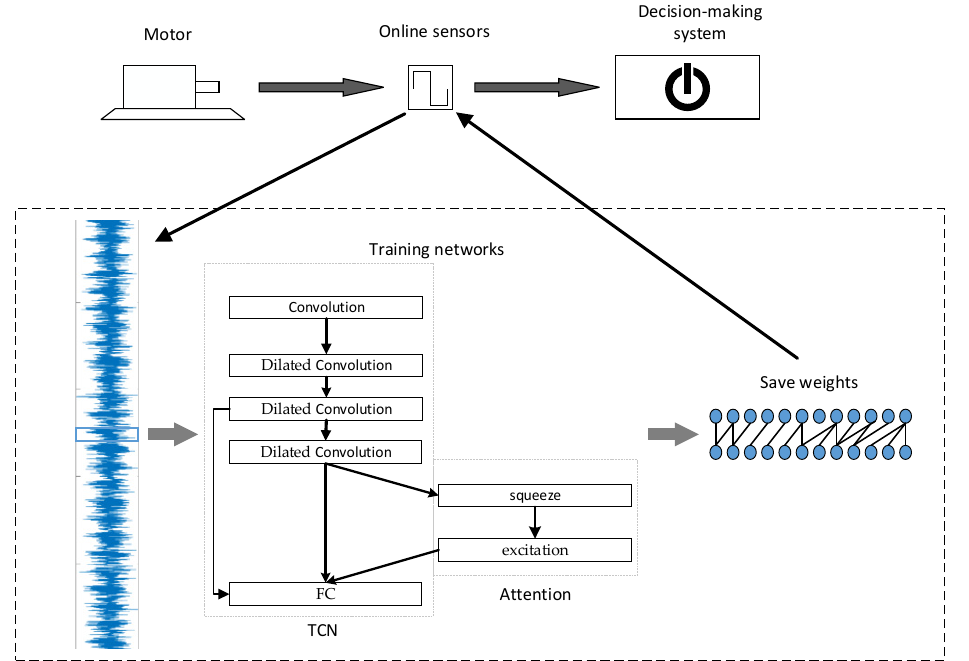
Figure 5. Motor fault online diagnosis system.